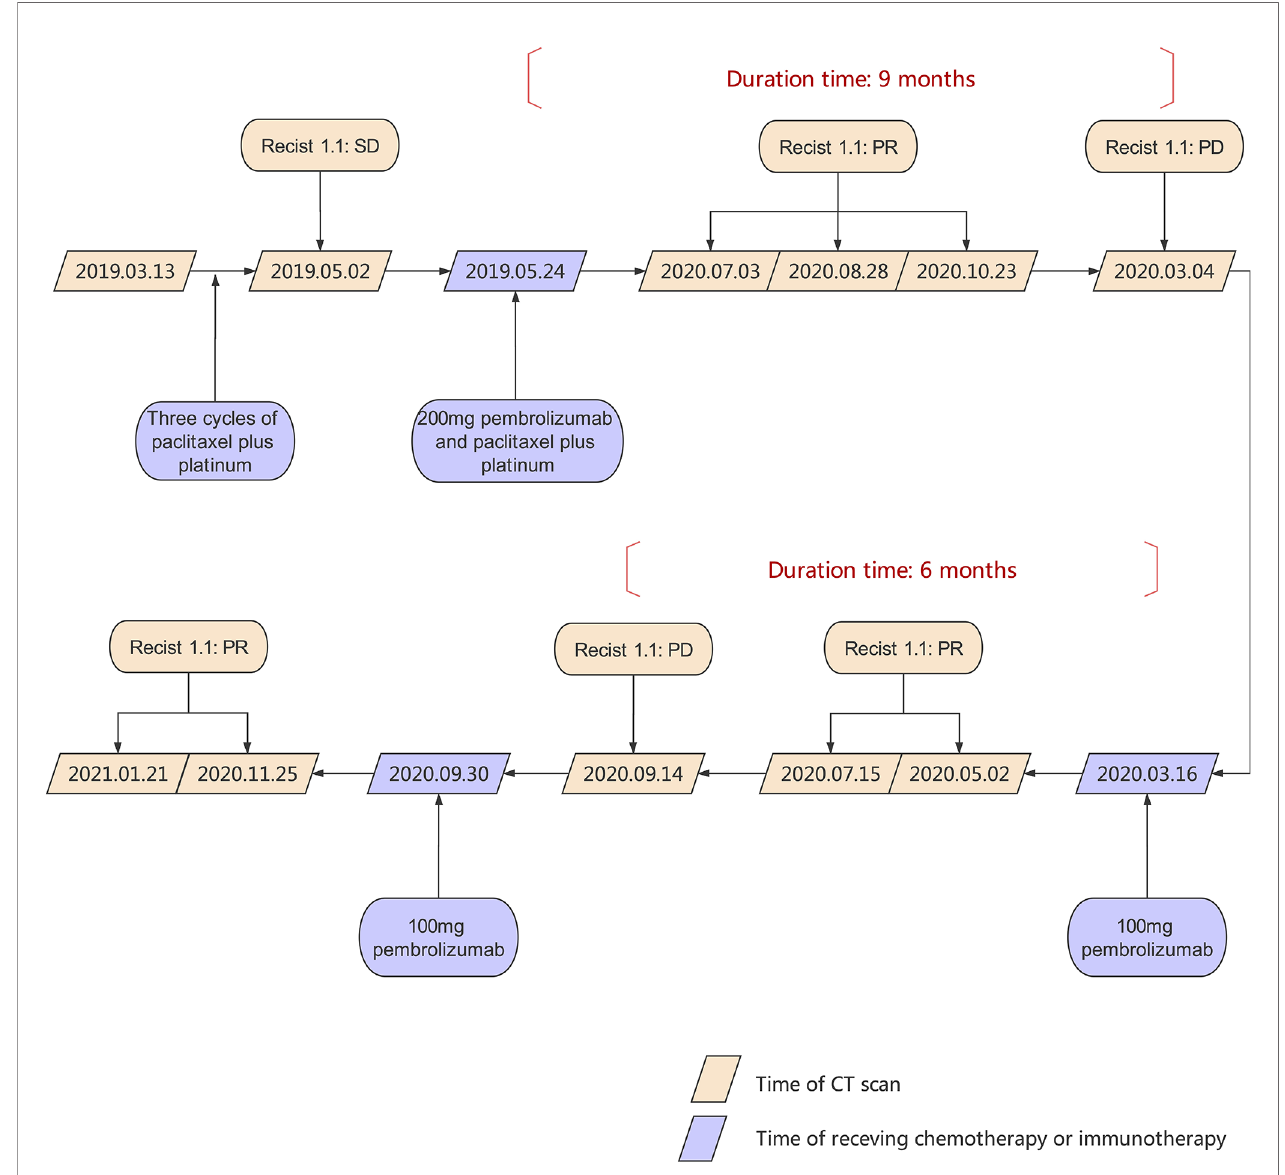
FIGURE 2 | Timeline scheme of major clinical event of the patient since